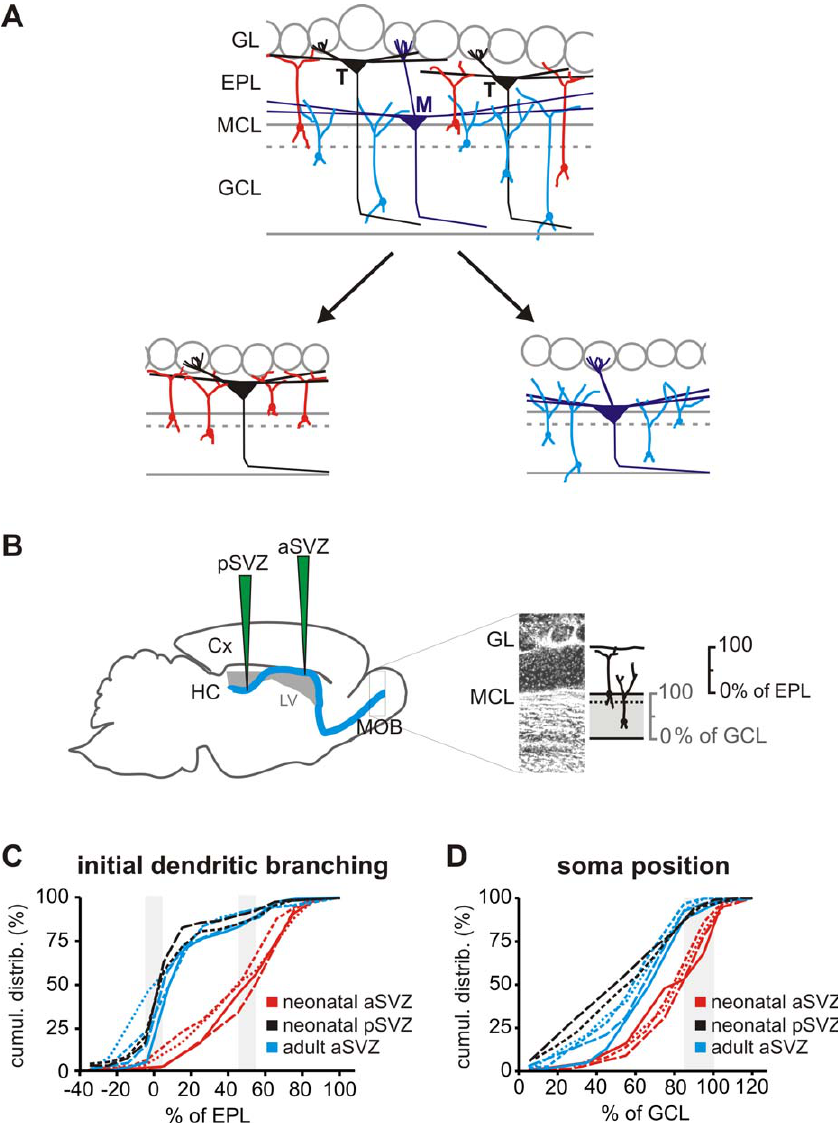
Figure 1. Distinct Precursors Gave Rise to Separate Populations of GCs with Initial Branching of the Apical Dendrite in Different Laminae of the EPL (A) GCs extend apical dendrites towards the EPL where they form synapses with the dendrites of mitral (M) and tufted (T) cells. The dendrites of one subpopulation of GCs (blue) initially branch near the MCL, whereas the dendrites of the other population of GCs (red) first branch in the superficial lamina of the EPL. Mitral cells (M) extend their lateral dendrites in the deep lamina of the EPL, whereas (middle) tufted cells (T) soma are located in the superficial lamina of the EPL, and extend their dendrites in the superficial EPL. GL, glomerular layer. (B) Sites for labeling of GC precursors in the aSVZ and pSVZ with a retroviral vector expressing GFP. For quantification of the position of the soma and of the initial branching of the apical dendrite, the GCL and the EPL were divided in percentages, with 0% being the deep and 100% being the superficial border. (C) Cumulative distribution of initial branching points of the GC apical dendrite. A total of 50% of GCs originating in the anterior aSVZ of neonatal animals initially branched after passing 50% through the EPL. In contrast, over half the GCs derived from the pSVZ of neonatal animals, and GCs derived from the adult aSVZ, branched before they have projected through 10% of the EPL. Different time points were analyzed for aSVZ at 14 (dotted line [ ... . ]), 28 (short-dashed line [- - -]), 56 (long-dashed line [ _ _ _ ]), and 112 d.p.i. (solid line [ ___ ]), and for pSVZ at 35 (short-dashed line [- - -]) and 63 d.p.i. (long- dashed line [ _ _ _ ]). (D) Cumulative distribution of the soma position in the GCL of GCs generated from the different SVZ precursor populations shown in (C). Same labeling as in (C). single cohort of immature GCs in the olfactory bulb. At 14 and 21 d after retroviral labeling of precursors in adult rats, only 8.7% ( n ¼ 922) and 0.8% ( n ¼ 615), respectively, of the total number of cells labeled were still found migrating in the RMS of the olfactory bulb.